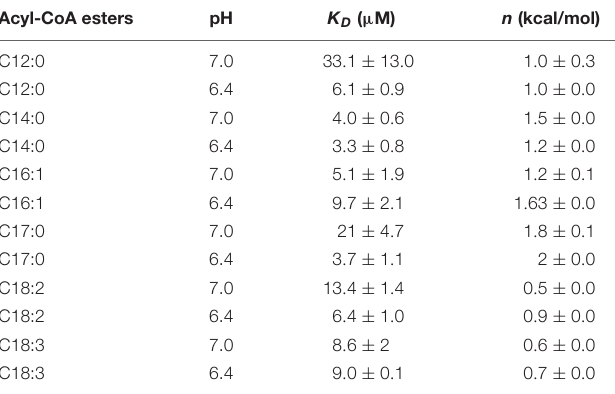
TABLE 1 | Dissociation constants between (His) 6 -AtACBP3 and acyl-CoA esters.